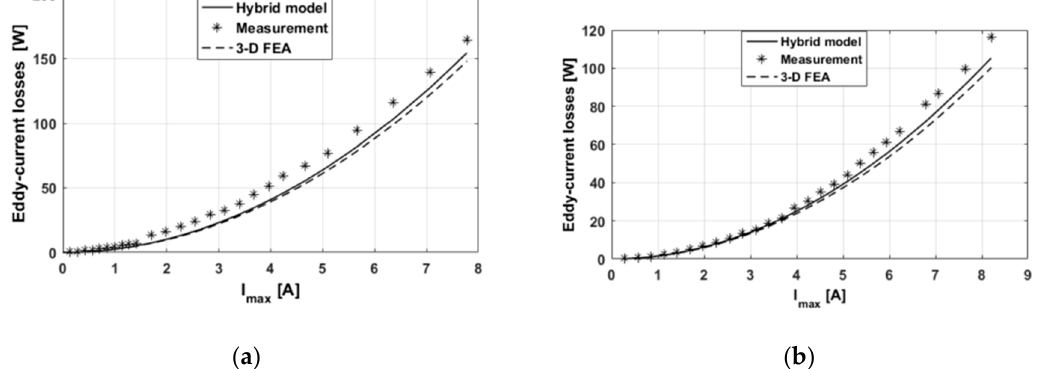
Figure 16. Validation of eddy-current losses (analytical, numerical, and experimental) in massive conductive parts versus I max with M l s = L l s = R l s for: ( a ) h mp = 6mm and ( b ) h mp =